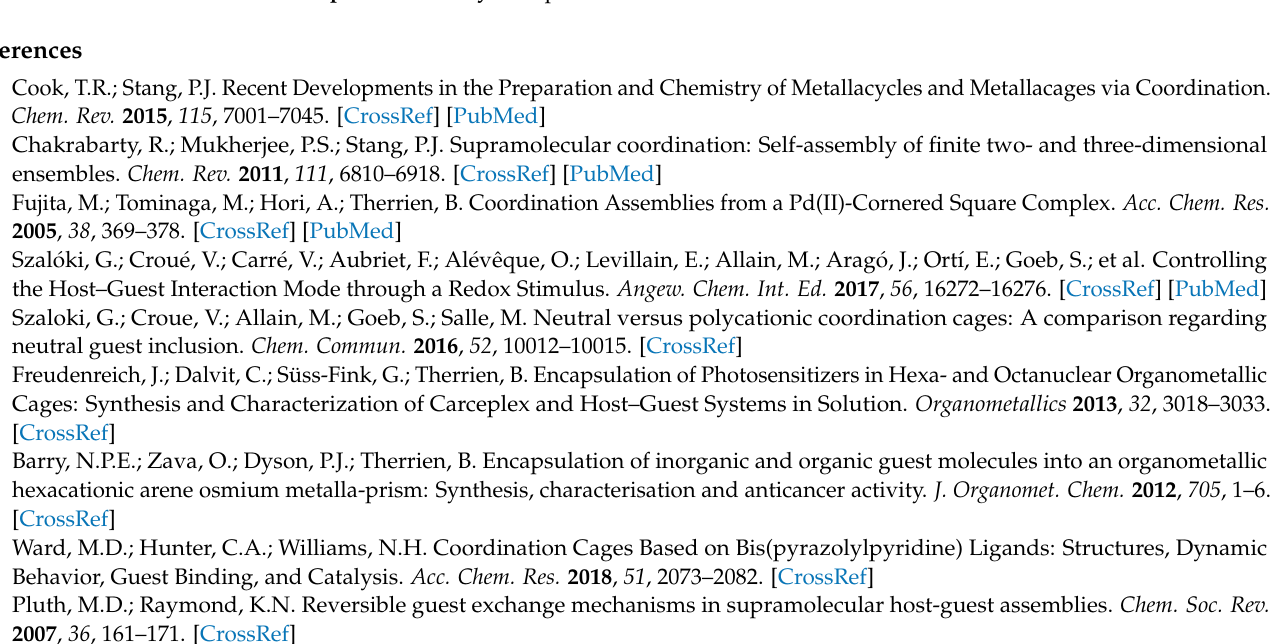
Figure S34: Monitoring the formation of salt CT-2 ( 1:2 mixture of Ru 4 -6 and F 4 TCNQ) through IR spectroscopy; Figure S35: The UV–vis–NIR spectrum of CT-2 salt (1:2 mixture of Ru 4 -6 and F 4 TCNQ), together with those of the neutral complex, neutral F 4 TCNQ, oxidized complex [Ru 4 -6] 2+ , and mono- reduced F 4 TCNQ; Figure S36: EPR spectrum of salt CT-2 .; Figure S37. Powder X-ray diffraction (PXRD) pattern of the charge-transfer salt CT-1 ( [Ru 4 -5] 2+ [F 4 TCNQ] 2 − ); Figure S38. Powder X- ray diffraction (PXRD) pattern of the charge-transfer salt CT-2 ( [Ru 4 -6] 2+ [F 4 TCNQ] 2 − ). Table S1: Crystal data and structure refinement for Ru 4 -5 ; Table S2: Data of cyclic voltammetric measurements of tetraruthenium macrocycle Ru 4 -5 at different scan rates in THF/ n Bu 4 NPF 6 ; Table S3: Data of cyclic voltammetric measurements of tetraruthenium macrocycle Ru 4 -6 at different scan rates in THF/ n Bu 4 NPF 6